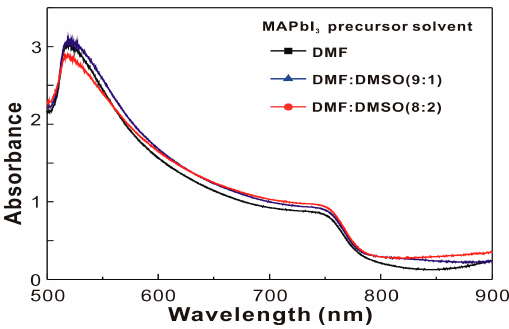
Figure 3. Absorbance spectra of MAPbI 3 /C 60 /ITO/glass samples.